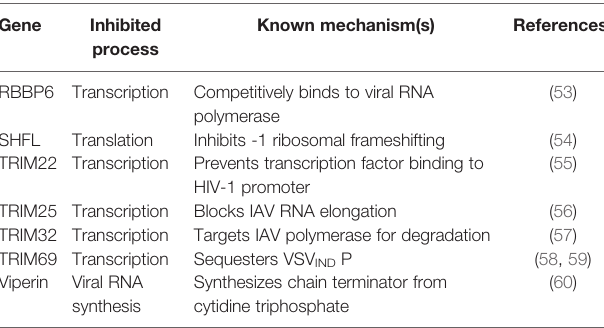
TABLE 2 | ISGs that inhibit viral RNA processes with no known dependence on RNA